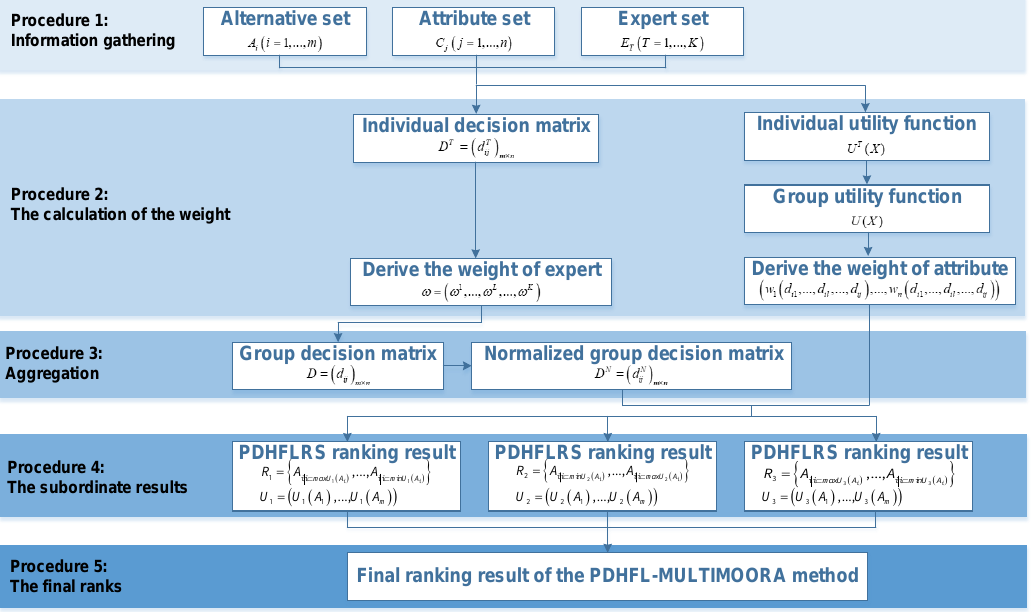
Figure 2. The structure of the possibility distribution based hesitant fuzzy linguistic-MULTIMOORA (PDHFL-MULTIMOORA) method.